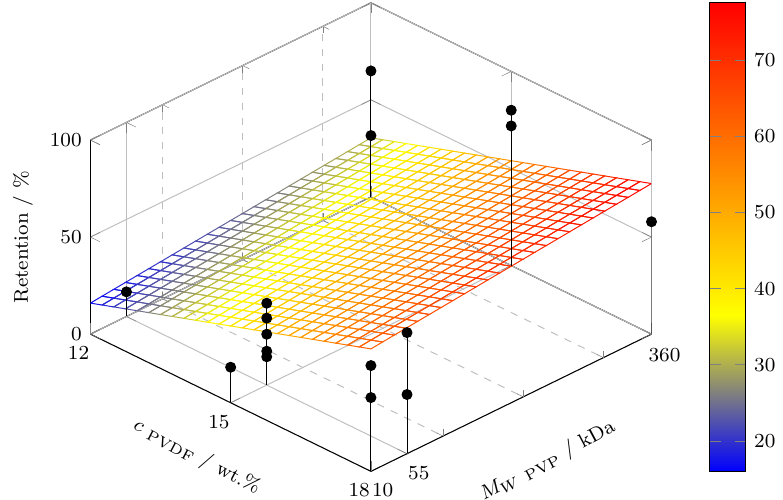
Figure 2. Regression hyperplane showing the linear fit of retention to PVDF concentration and PVP molecular weight at T Dope = 35 ◦ C, T H = 35 ◦ C, c PVP = 5%, M W PVDF = 585 kDa. Black dots represent 2 O experimental values of entire design space ( n =